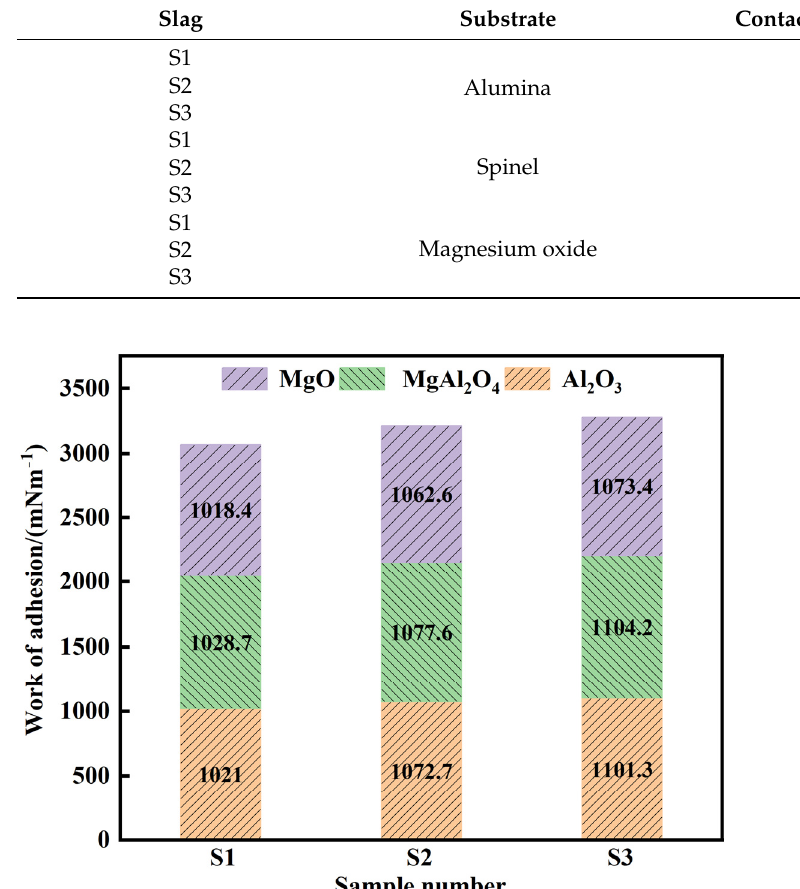
Figure 10. Adhesion work between the Al 2 O 3 , MgAl 2 O 4 , and MgO inclusions in various re fi ning